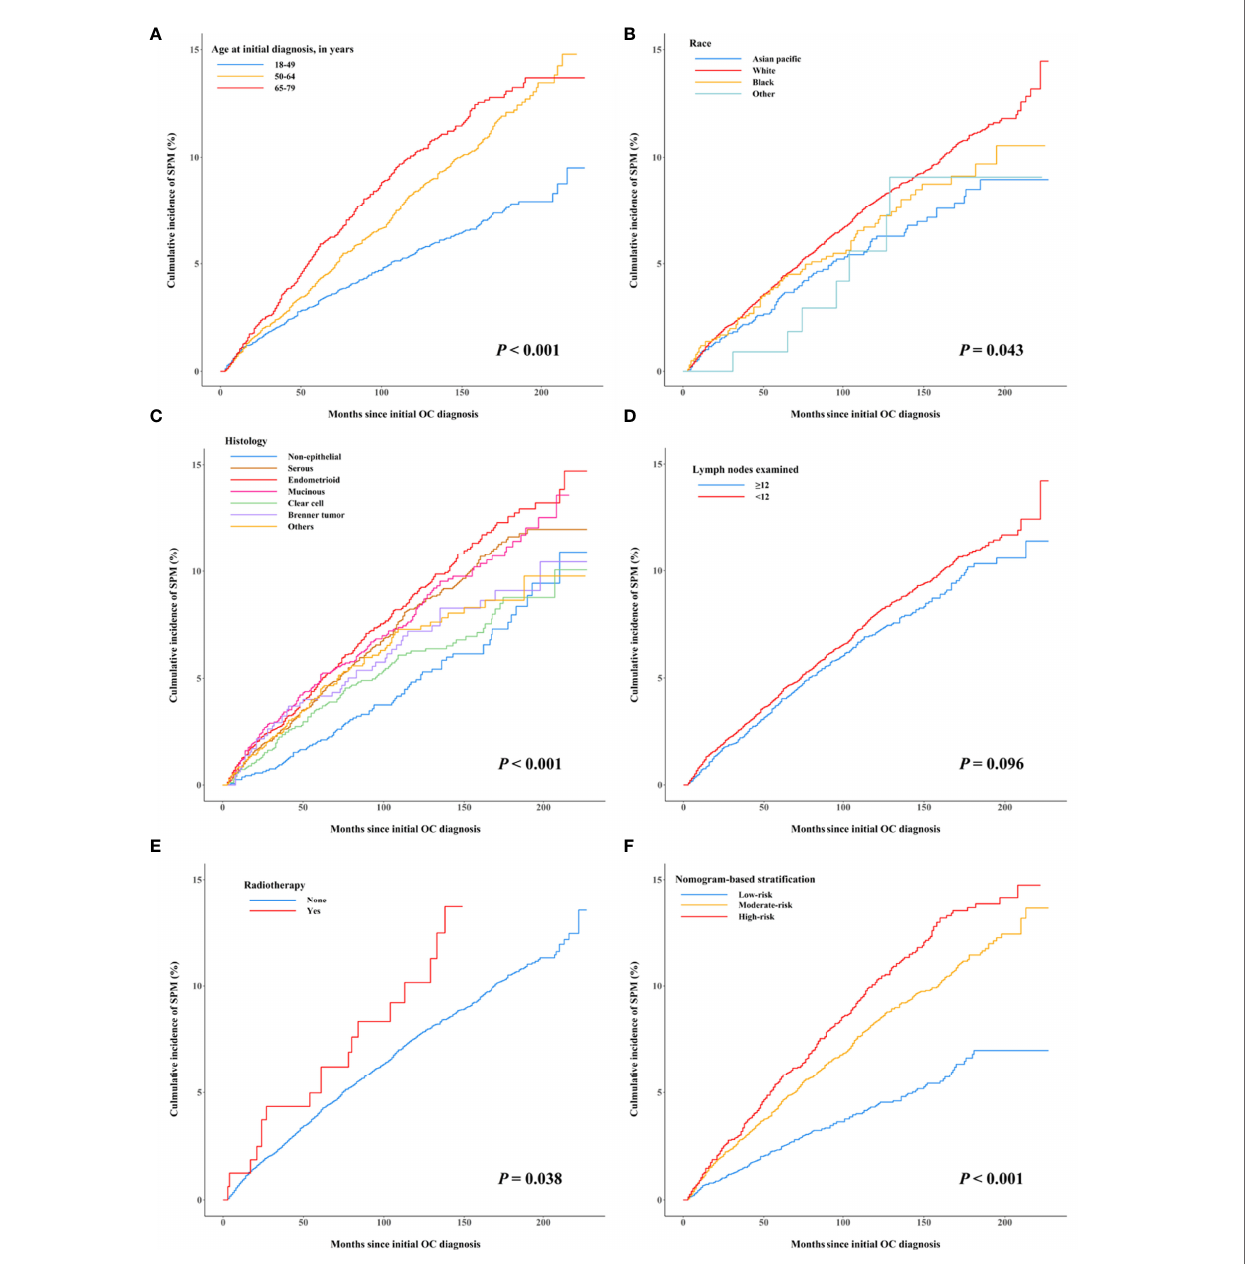
FIGURE 2 | Cumulative incidence curves of early-stage OC patients developing second primary malignancies after their initial diagnosis by subgroups, treating non-SPM death as a competing event. (A) Age at initial diagnosis, (B) race, (C) histology, (D) the number of lymph nodes examined, (E) radiotherapy, and (F) nomogram-based risk strati fi